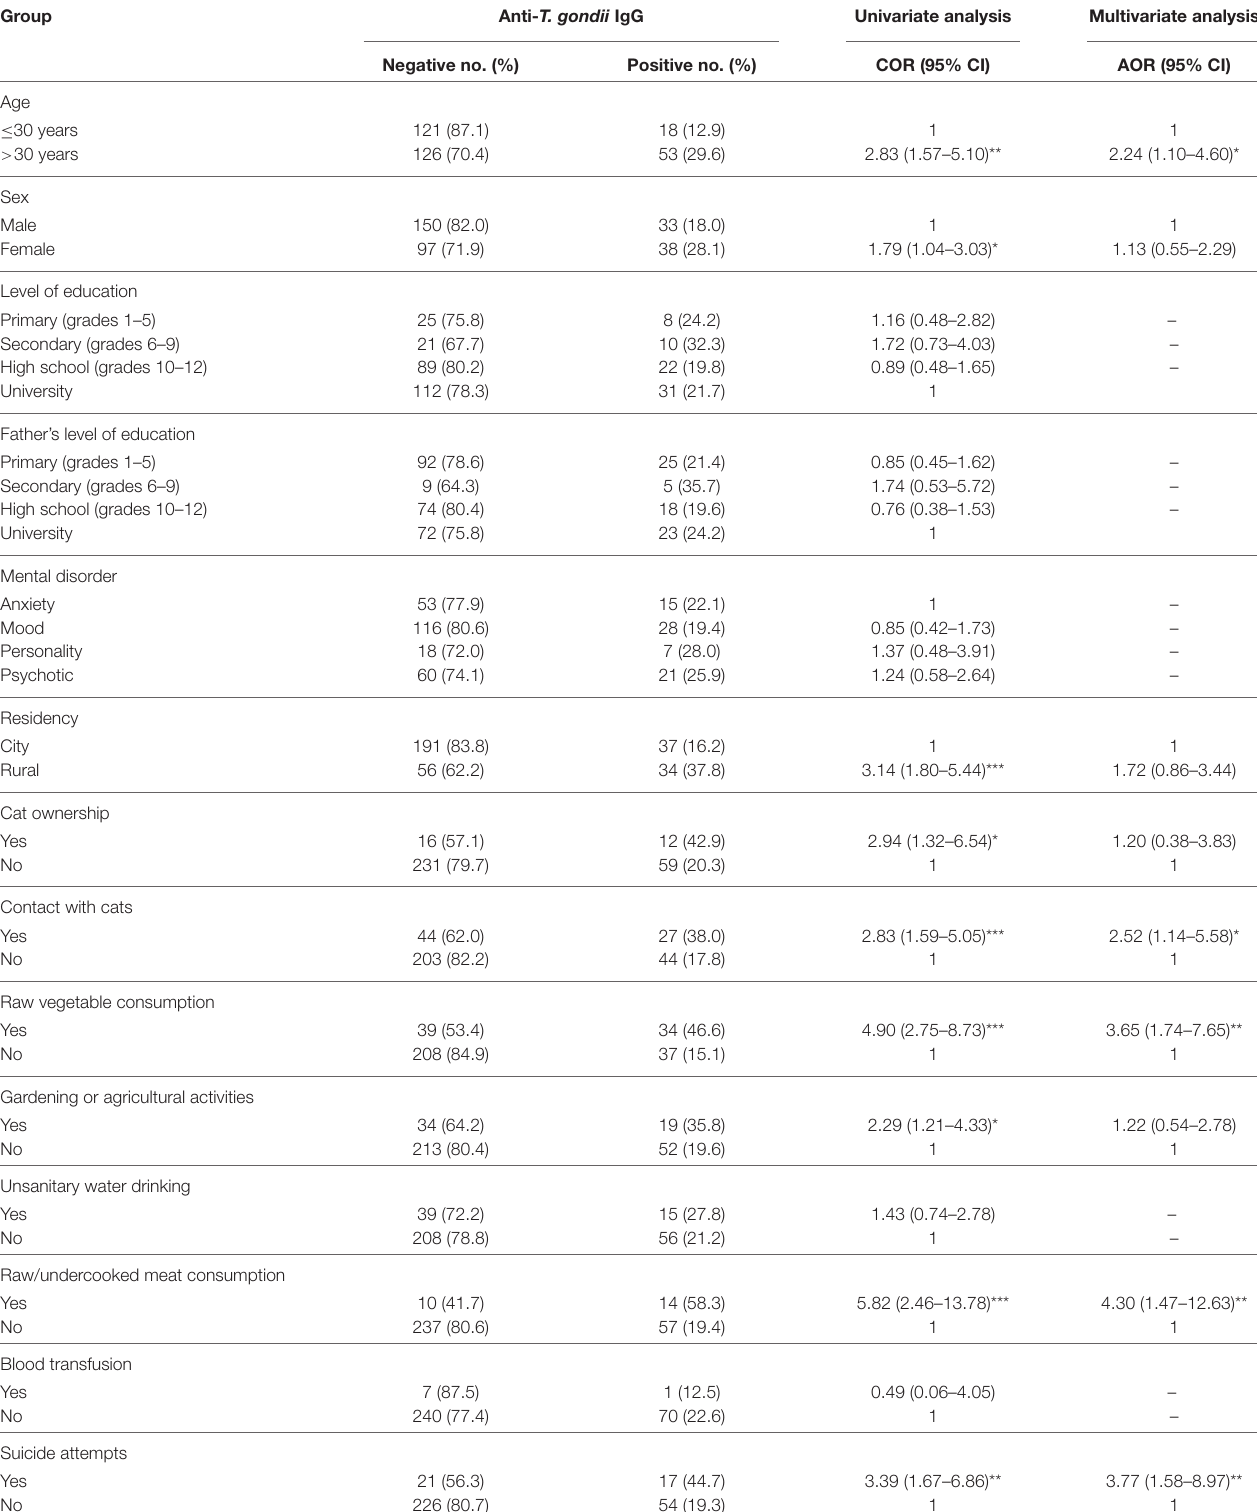
TABLE 2 | Logistic regression analysis of the risk factors associated to anti- T. gondii IgG in 318 psychiatric patients based on univariate and multivariate analyses. Group Anti- T. gondii IgG Univariate analysis Multivariate